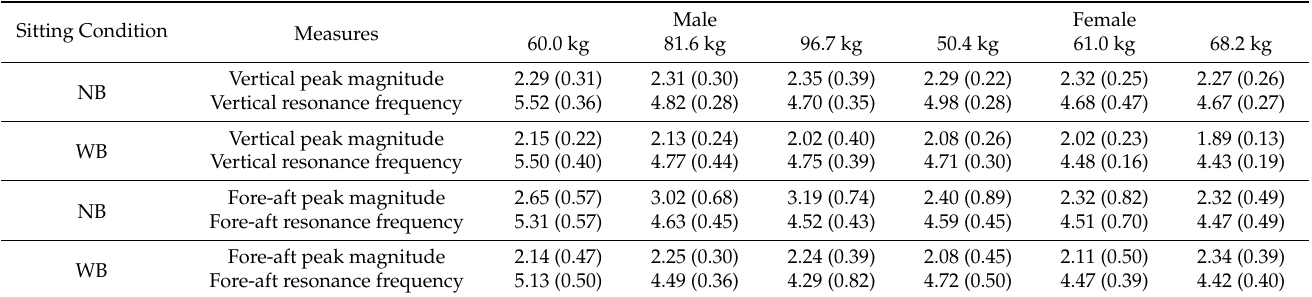
Table 5. Means (standard deviations) of peak vertical and fore-aft STHT magnitudes and corre- sponding frequencies of male and female subjects within three ranges of body mass and two sitting conditions (0.50 m/s 2 excitation).